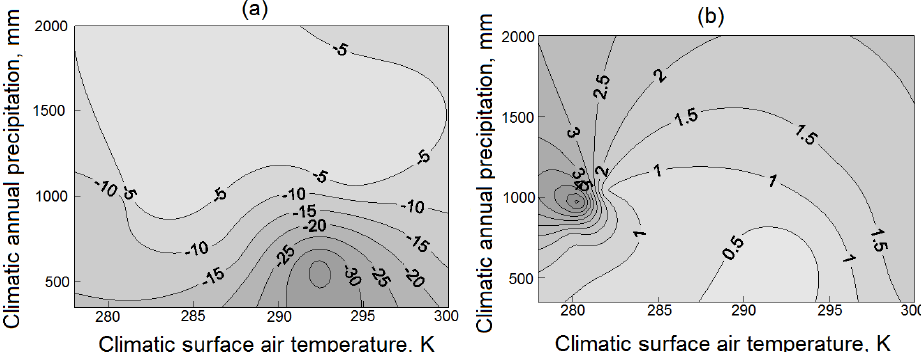
Figure 3. Temperature elasticity of runoff ε T (a) and precipitation elasticity of runoff ε P (b) . The elasticities are shown in